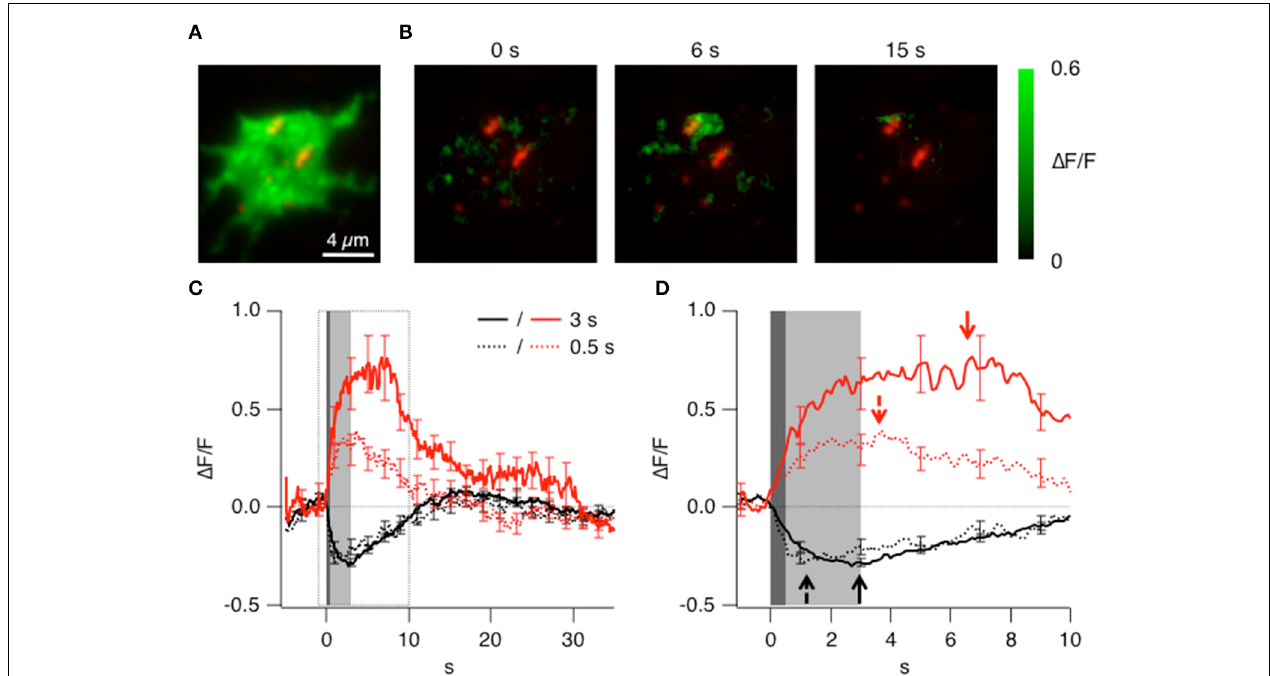
FIGURE 3 | Triggered accumulation of clathrin at the active zones. (A) TIRF image of the synaptic terminal of a bipolar cell isolated from a fish generated by crossing Ribeye:LCa-EGFP and Ribeye:Ribeye-mCherry fish. (B) Images showing the relative change in fluorescence of LCa-EGFP at 0, 6, and 15s delay relative to the start of a depolarizing stimulus lasting 3s. Note the